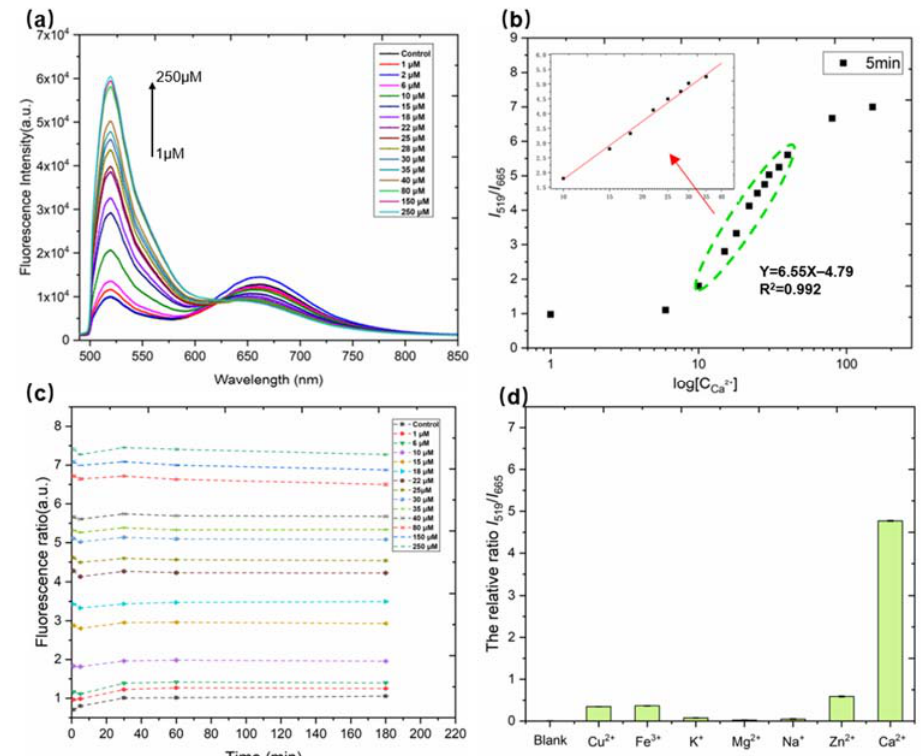
Figure 4. ( a ) Fluorescence spectra of the ratiometric probe (Cal Red R525/650) solution when different concentrations of Ca 2+ were added. The concentrations of Ca 2+ from bottom to top are 0, 1, 2, 6, 10, 15, 18, 22, 25, 28, 30, 35, 40, 80, 150, and 250 μ M, respectively. ( b ) The relationship between the fluorescence intensity ratio (I 519 /I 655 ) and different concentrations of Ca 2+ (log [Ca 2+ ]). ( c ) Time- dependent fluorescence intensity ratio I 519 /I 655 of the ratiometric probe (between 0 and 180 min). ( d ) Selectivity tests for the probe were conducted. Error bar indicates mean ± SD for three measure- ments at different